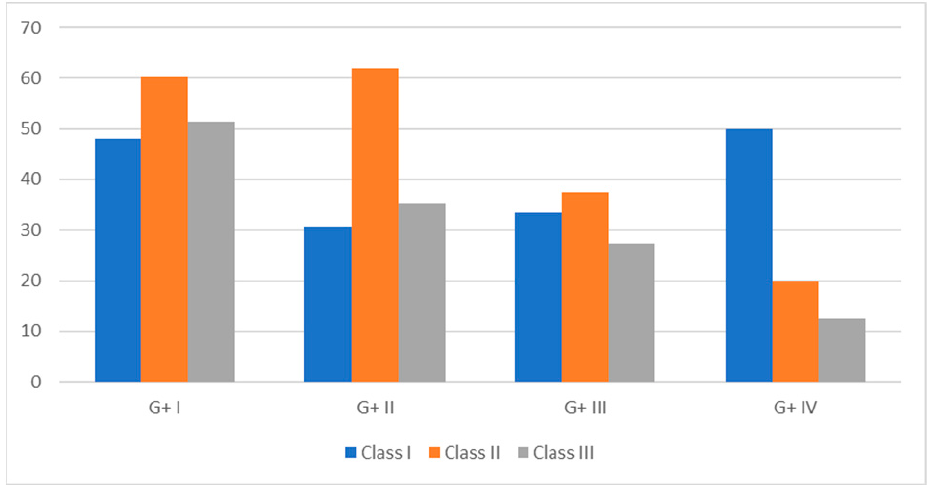
Figure 2. Pregnancy rate recorded throughout the study in buffaloes with different days in milk (Class I: <90 DIM; Class II: 91–150 DIM; Class III: >151 DIM). Excluding buffaloes pregnant at TAI, the mean interval between the end of treatment and conception was significantly ( p < 0.05) higher for animals in Class I compared with those in Classes II and III (48.2 ± 4.1 days in Class I vs. 27.5 ± 2.4 and 34.6 ± 4.7 days in Classes II and III,